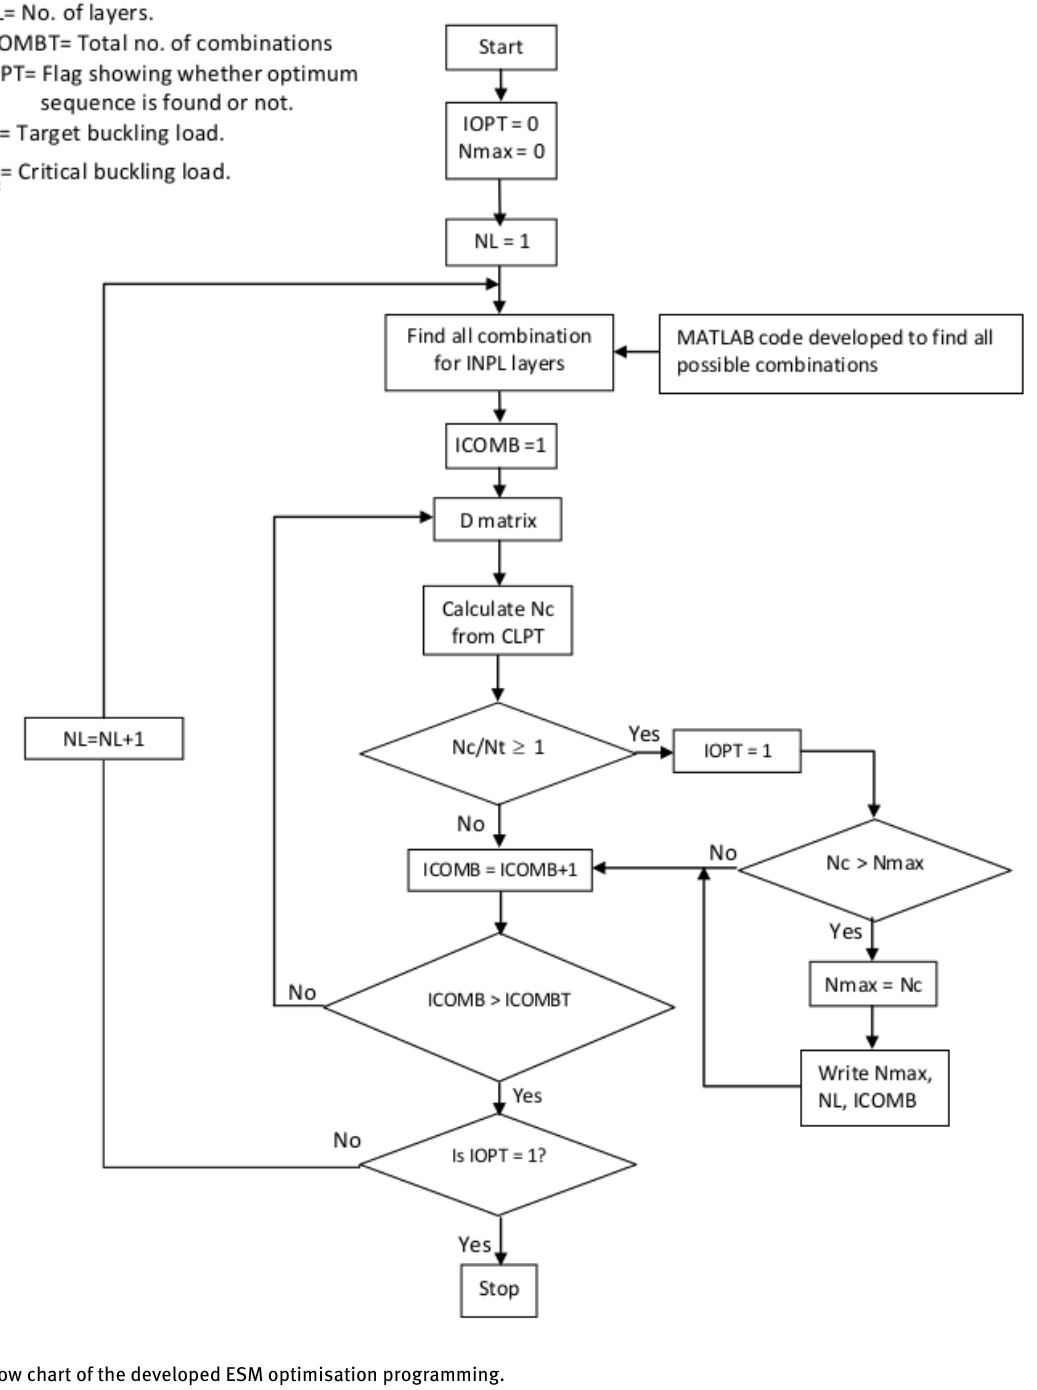
Figure 2: Flow chart of the developed ESM optimisation programming.